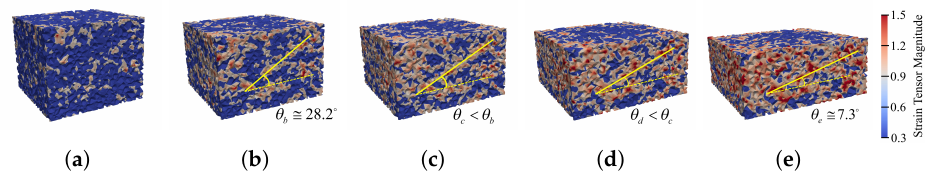
Figure 15. The micro-strain contour evolution during the compaction process of specimen S 7 , ( a ) (cid:101) 3 = 0.1, ( b ) (cid:101) 3 = 0.2, ( c ) (cid:101) 3 = 0.3, ( d ) (cid:101) 3 = 0.4, ( e ) (cid:101) 3 =